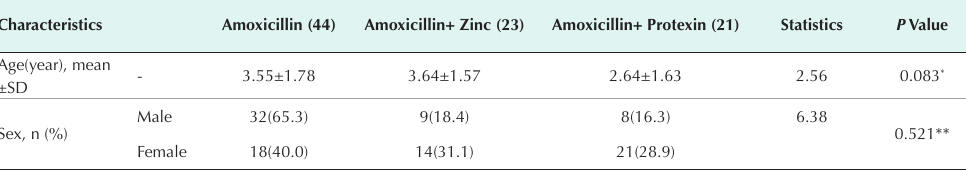
Table 1. Baseline Characteristics (Age and Sex) of Patients in Three Groups Characteristics